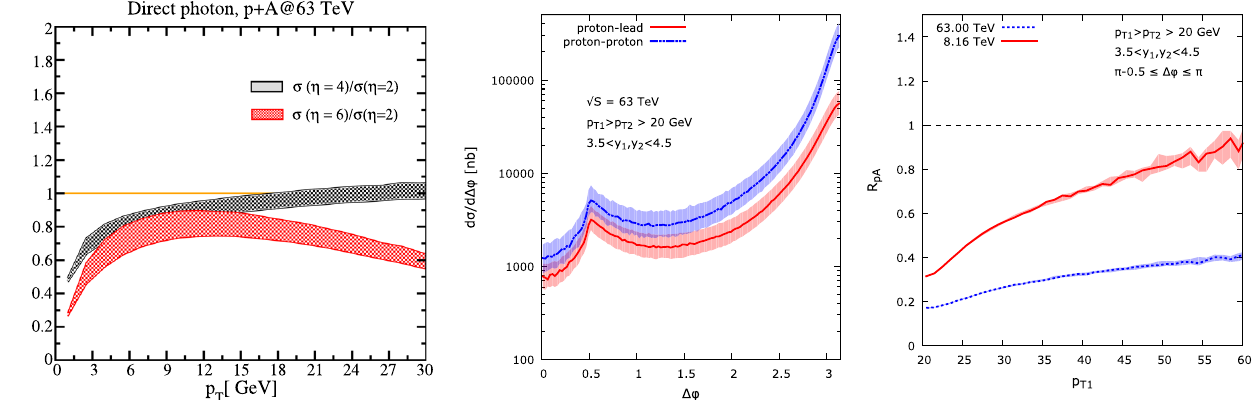
Fig. 16.7 Left: ratio of direct photons at forward rapidities η = 2 , 4 , 6 obtained in the CGC formalism in pPb collisions [423,424]. Middle: Forward dijet (cid:4)ϕ correlation in pPb compared to pp collisions at FCC [426]. Right: nuclear modification factor of back-to-back dijets at LHC and FCC energies